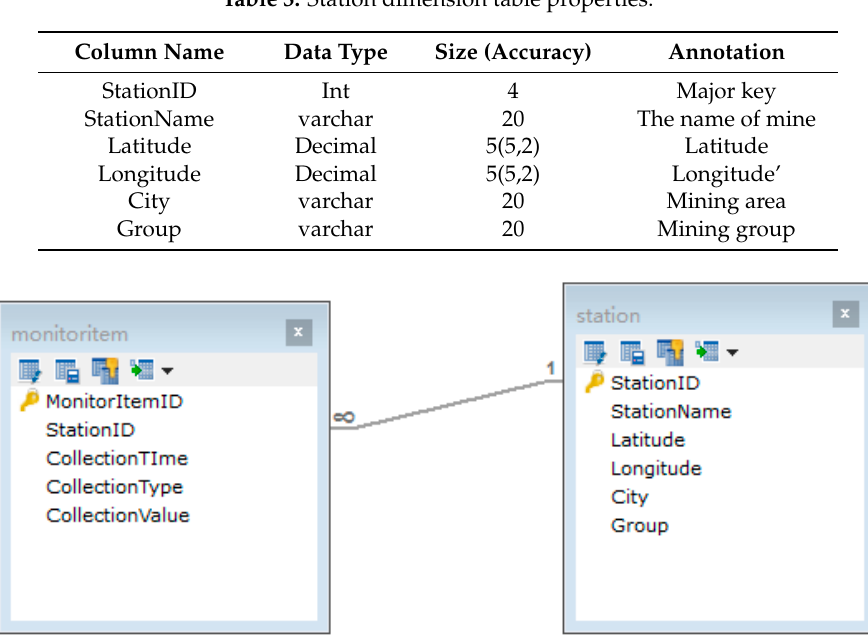
Table 3. Station dimension table properties.